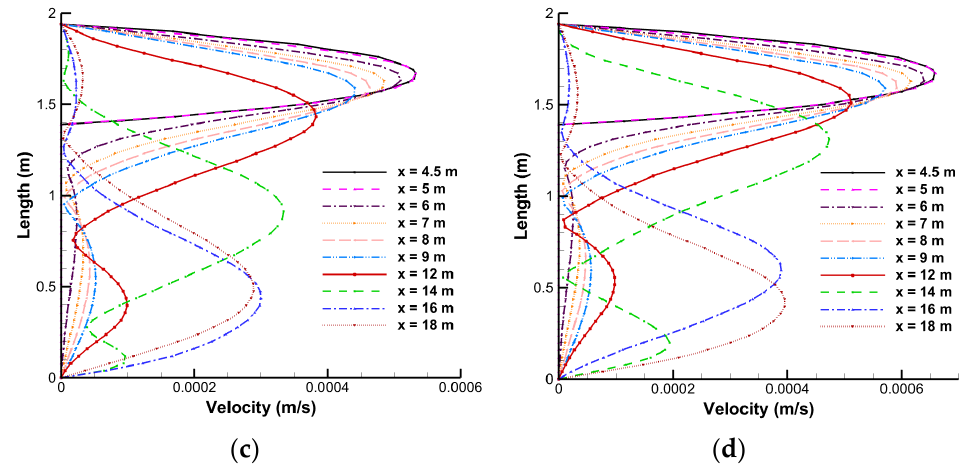
Figure 8. Velocity profiles for Reynolds numbers at various lengths along the lateral directions from inlet boundary; ( a ) 200, ( b ) 300, ( c ) 400, and ( d ) 500.